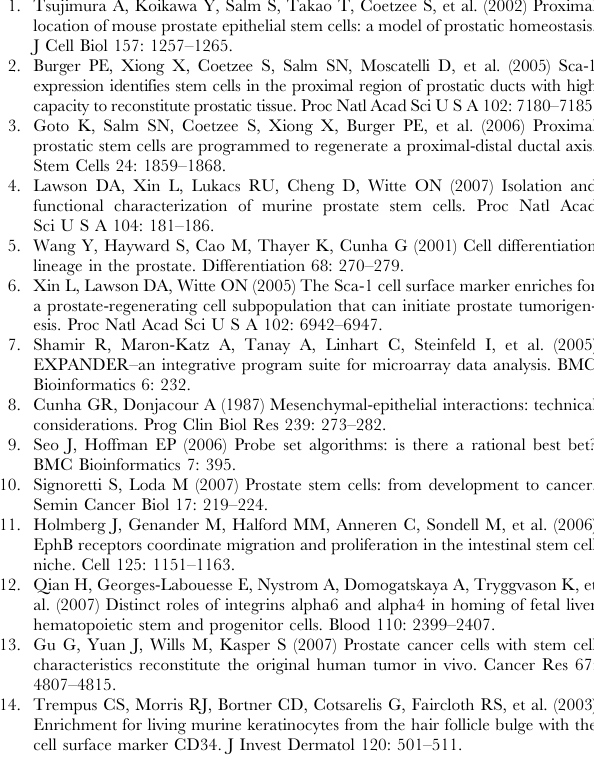
supplementary Table 1 of Zavadil et al. (2001) Proc. Natl. Acad. Sci. USA 98 (12), 6686–6691. (10.1073/pnas.111614398). It includes genes that were up-regulated in at least one time point (0.3, 1, 2, 4 hr) after exposure to TGF- b . We compared the list of TGF- b -induced genes (Table A) with our data from three PSC clusters. The genes that are shared are depicted in the following tables: B) UGE-only, C) UGE + Sca-1Hi, D) Sca-1Hi-only. Table S15 Human prostate cancer signature compared with the murine PSC signature. Gene expression data generated by a screen that compared normal human prostate specimens with primary prostate tumors [60] were used for this analysis. Based on the two- group t-test (p , 0.05) we generated two lists of genes that were (i) up- or (ii) down- regulated in human prostate tumors. The up-regulated murine PSC profiles were compared with these two lists of genes. Each folder represents genes from a relevant PSC cluster that were either up- or down- regulated in human prostate tumors Found at: doi:10.1371/journal.pone.0005722.s016 (0.17 MB